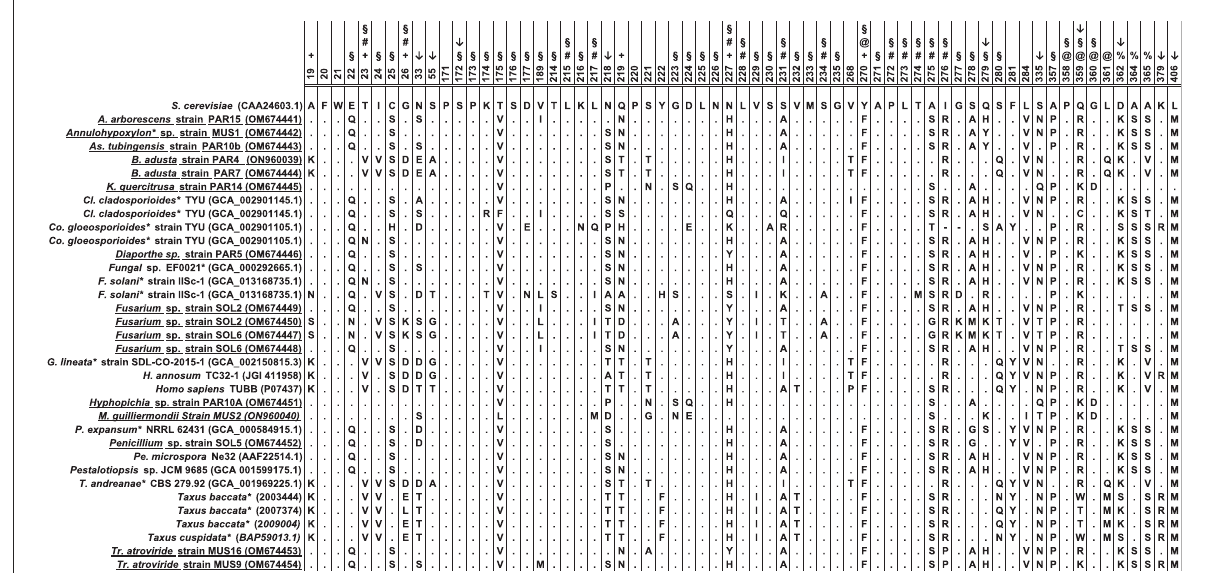
FIGURE5 Amino acid sequence comparison of the β -tubulin proteins. The alignment included fungi isolated in this study (shown underlined) and compared to published sequences from organisms that have been shown to produce paclitaxel (indicated with an asterisk), or other fungal endophytes (except for H. annosum ). For comparison, the β -tubulins from Taxus spp. and the most highly expressed human β -tubulin (P07437) were also included. Amino acids are numbered and used as consensus according to the β -tubulin protein of Saccharomyces cerevisiae (CAA24603.1). Symbols above the numbering indicate the following: + : the residues A19K, T23V, G26D, N227H, and Y270F which were mutated by Gupta et al. (2003) to create a paclitaxel-sensitive S. cerevisiae strain; #: the residues that were shown to interact directly with paclitaxel